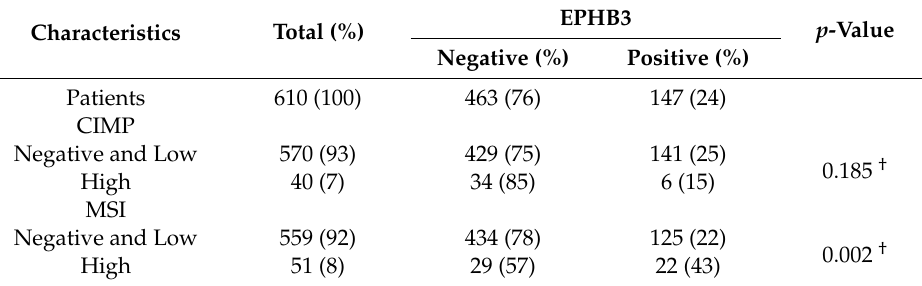
Table 2. Association between EPHB3 expression and molecular